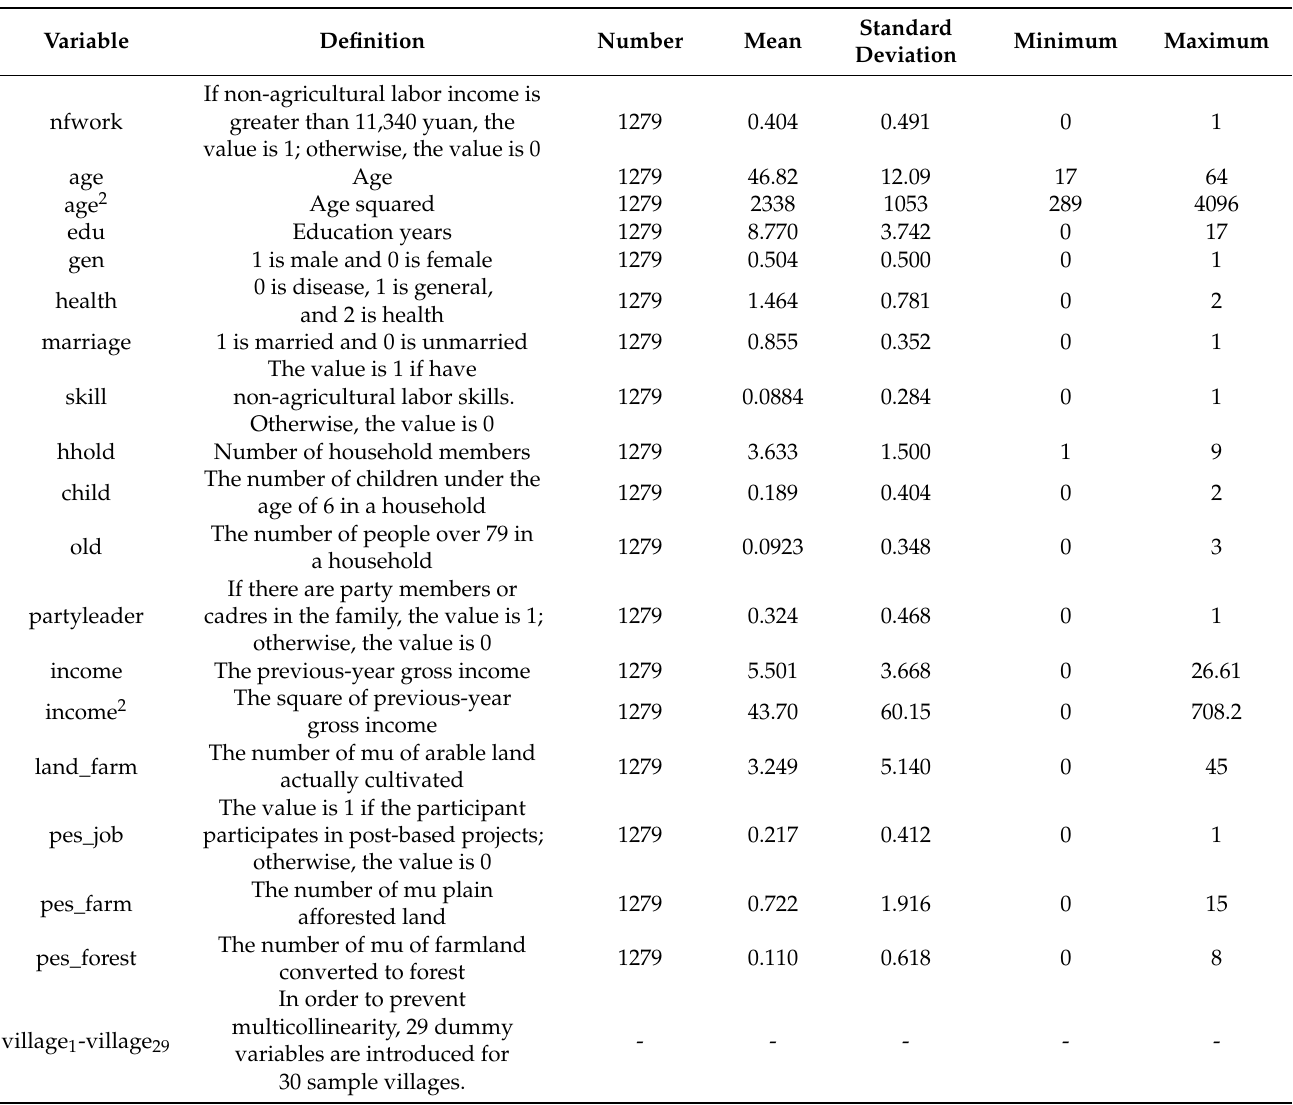
Table 1. Definitions and descriptive statistics of